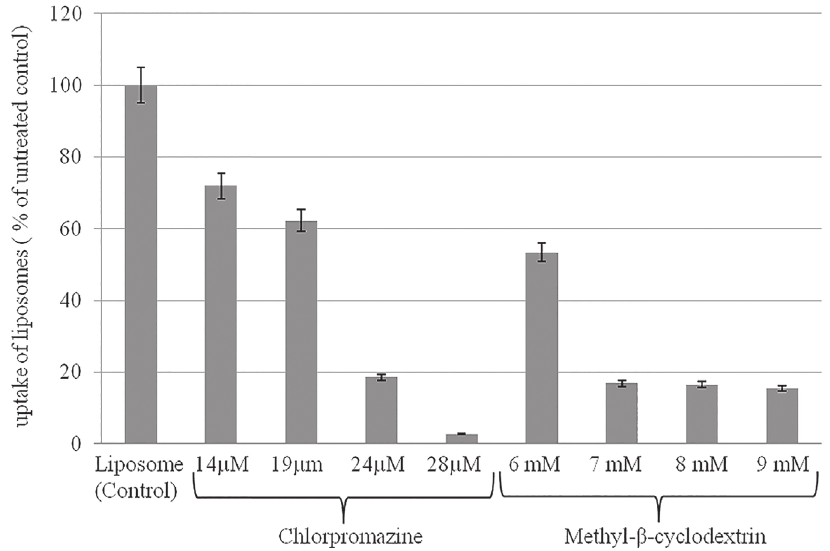
Fig 4. Effect of different endocytic inhibitors on cellular uptake of fluorescent liposomes. Flow cytometry analysis suggest clathrin mediated endocytosis as the dominant pathway for the internalization of fluorescently labeled liposomes by UROtsa cells at 37°C. Chlorpromazine (inhibitor of clathrin) dose dependently inhibited the internalization as cell fluorescence from externally bound non-internalized liposomes was quenched by sodium dithionite. Fluorescence intensity of liposomes in cells untreated with inhibitors was taken as 100%.